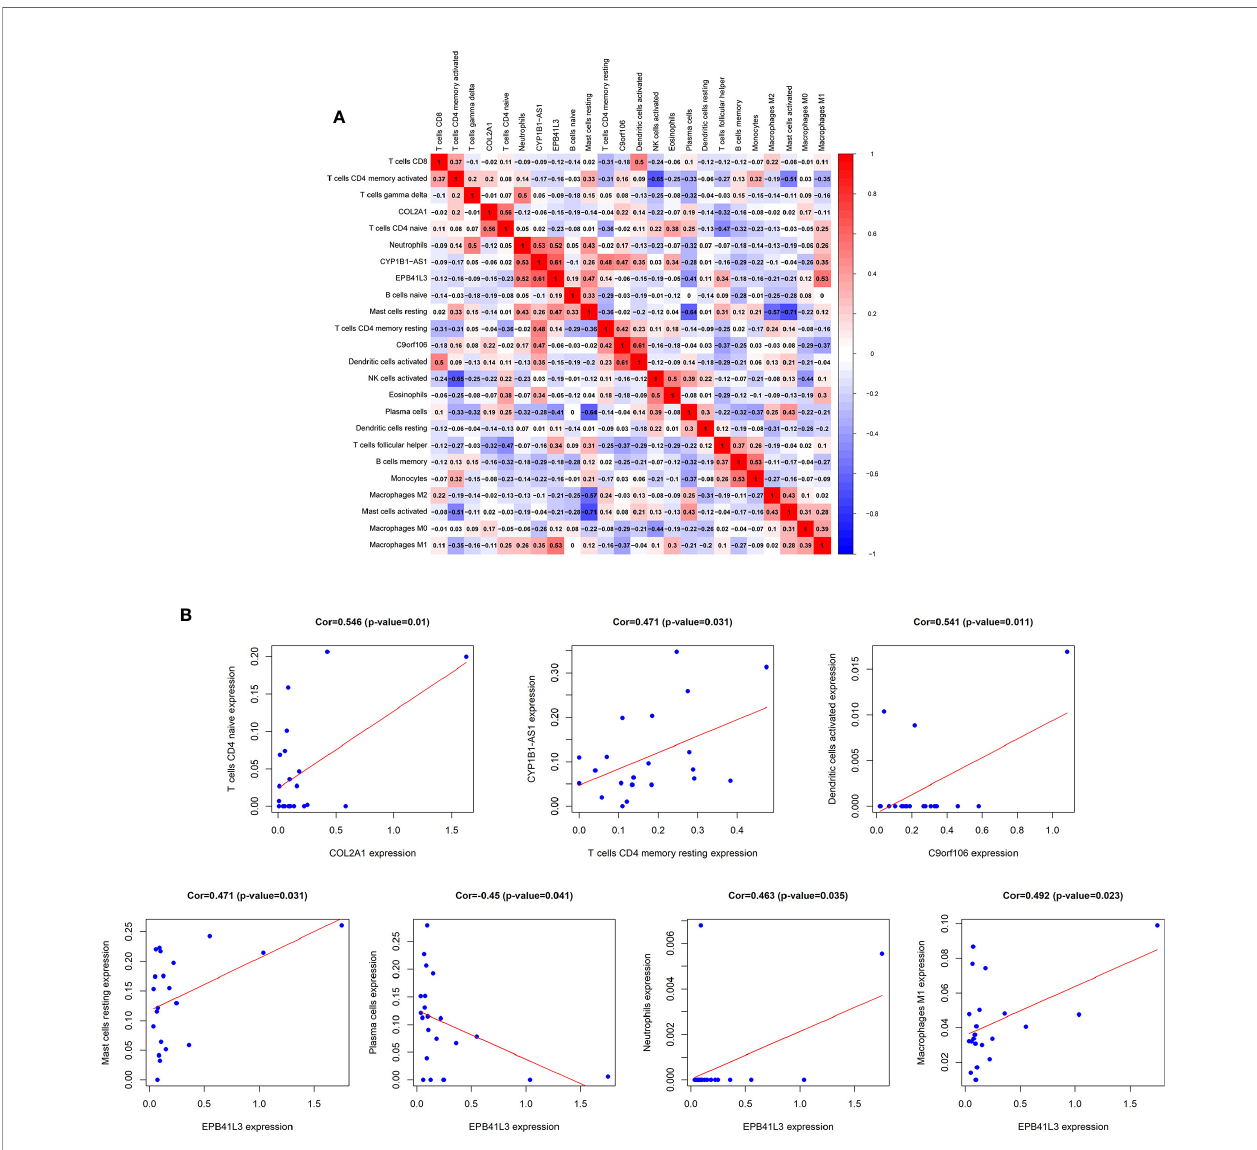
FIGURE 8 | Correlation analysis of hub prognostic ceRNA network and TME immune cells. (A) Correlation heat map between EPB41L3, COL2A1, CYP1B1-AS1, C9orf106, and TME in fi ltrating immune cells; (B) Verifying the correlation between EPB41L3, COL2A1, CYP1B1-AS1, C9orf106, and immune cells: EPB41L3 was signi fi cantly positively correlated with resting mast cells, neutrophils, and M1 macrophages, and had strong negative correlation with plasma cells, COL2A1 was positively correlated with naive CD4 T cells. CYP1B1-AS1 was positively correlated with resting CD4 memory T cells. C9orf106 was positively correlated with activated dendritic cells (all P values